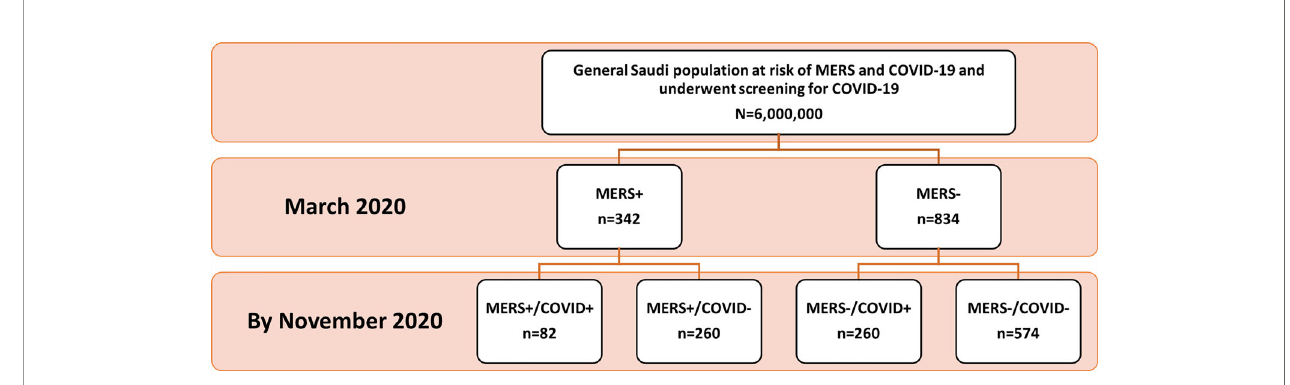
FIGURE 1 | Patient Disposition Flowchart. Out of 6,000,000 people who underwent the national screening on March 2020, 342 patients with a previously con fi rmed MERS-CoV infection and did not test positive for SARS-CoV-2 infection were identi fi ed. The random sample of the control group was taken approximately to be 3